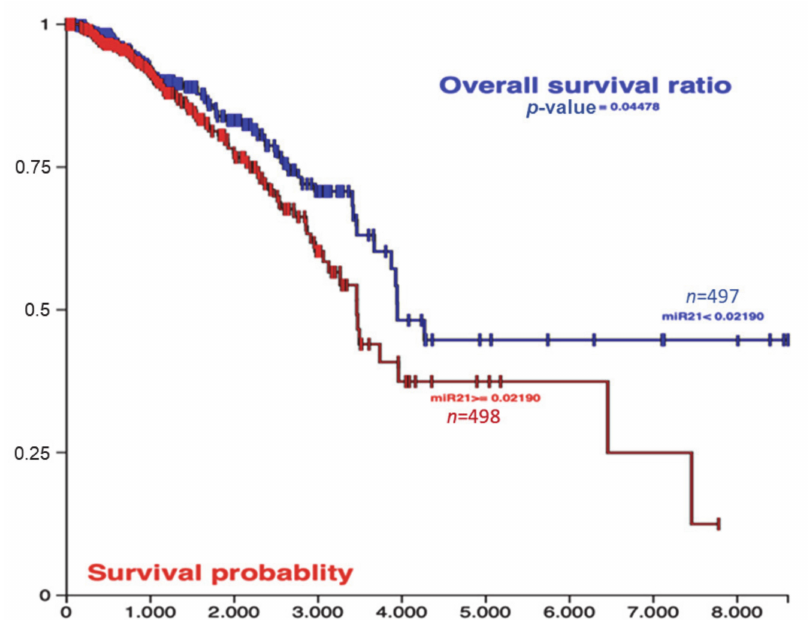
Figure 1. TCGA Breast Cancer (BRCA) database results were analyzed by the UCSC Xena tool [59] according to the expression profile of miR-21, low or high. Kaplan–Meier plots were used for the overall survival ratio for miR-21 low and high expression profile patients (995 patients in total). x-axis survival time cutoff, y-axis survival